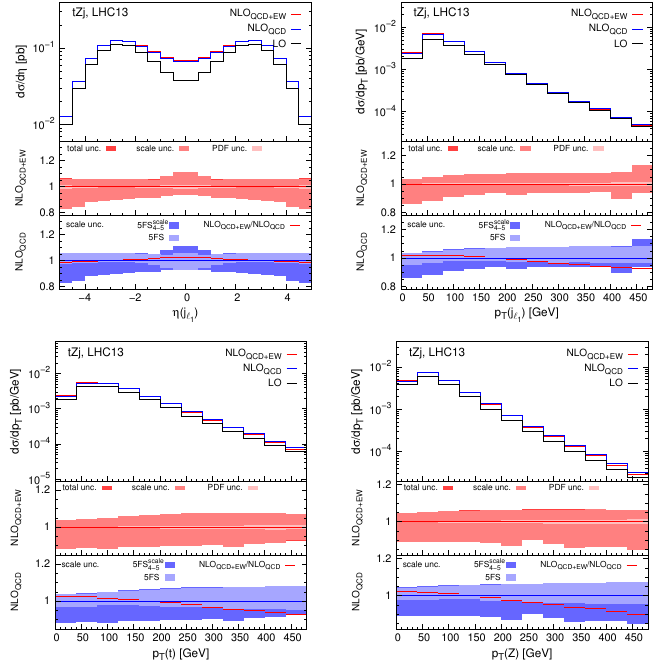
Figure 5 . NLO QCD+EW predictions for tZj . The layout of the plots is the same of (cid:12)gure 4.